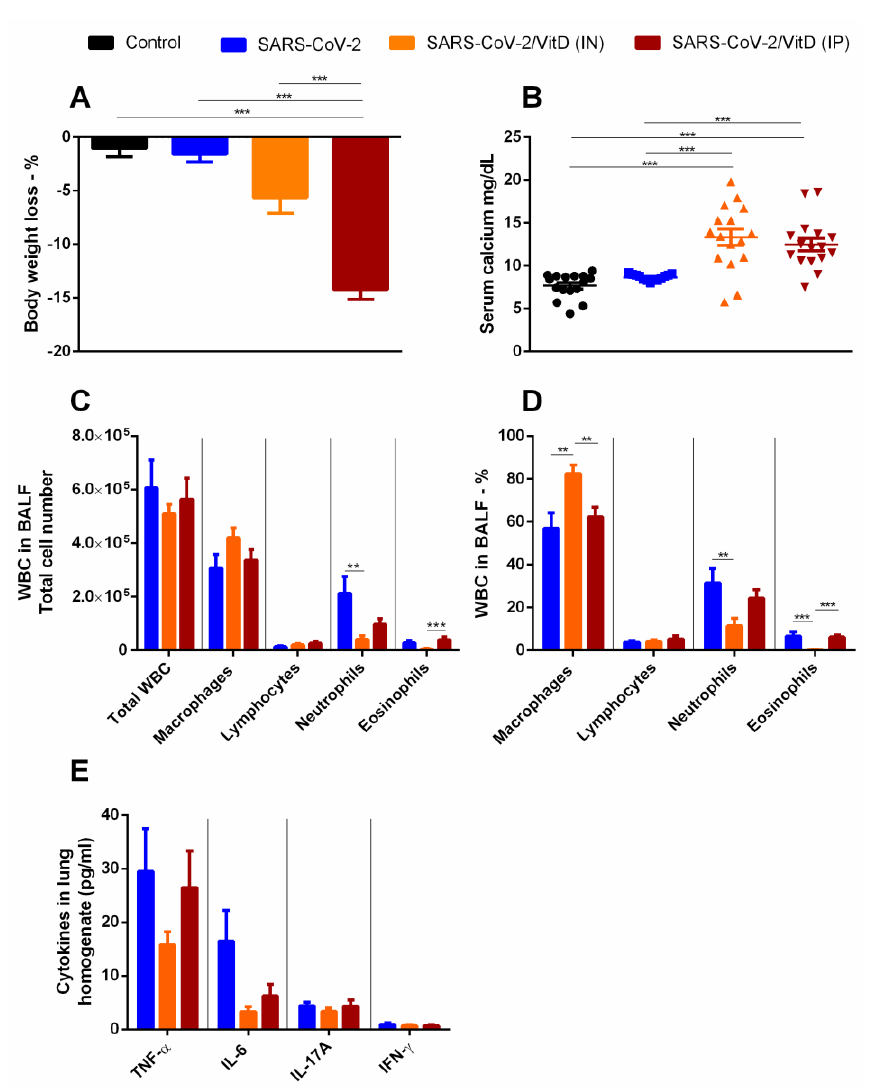
Figure 3. VitD effects on body weight, serum calcium levels, BALF cell counts, and cytokine levels in lung homogenates form mice of mice instilled with inactivated SARS-CoV-2. C57BL/6 mice were instilled with the virus (3 doses of 4 × 10 5 PFU/each) on days 1, 3, and 5. Body weight was checked daily and, at the 7th day, we collected blood samples for calcium measurement, BALF for WBCs analysis, and lower left lobe for cytokine quantification. Body weight loss ( A ), serum calcium levels ( B ), total WBCs, and WBCs subsets in BALF ( C ), percentage of WBCs in BALF ( D ), and cytokines in lung homogenates ( E ). Data shown in ( A , B , D ) derive from 3 experiments which were combined (n = 5 mice/experimental group). Data shown in ( A , C – E ) derive from 2 experiments with similar results which were combined (n = 16 mice/experimental group). The results are expressed as mean ± SEM and the comparison between the groups was performed using an ANOVA followed by Tukey’s test. The results shown in ( B ) are expressed as median and interquartile intervals and the comparison between the groups was performed by the Kruskal–Wallis test followed by Dunn’s